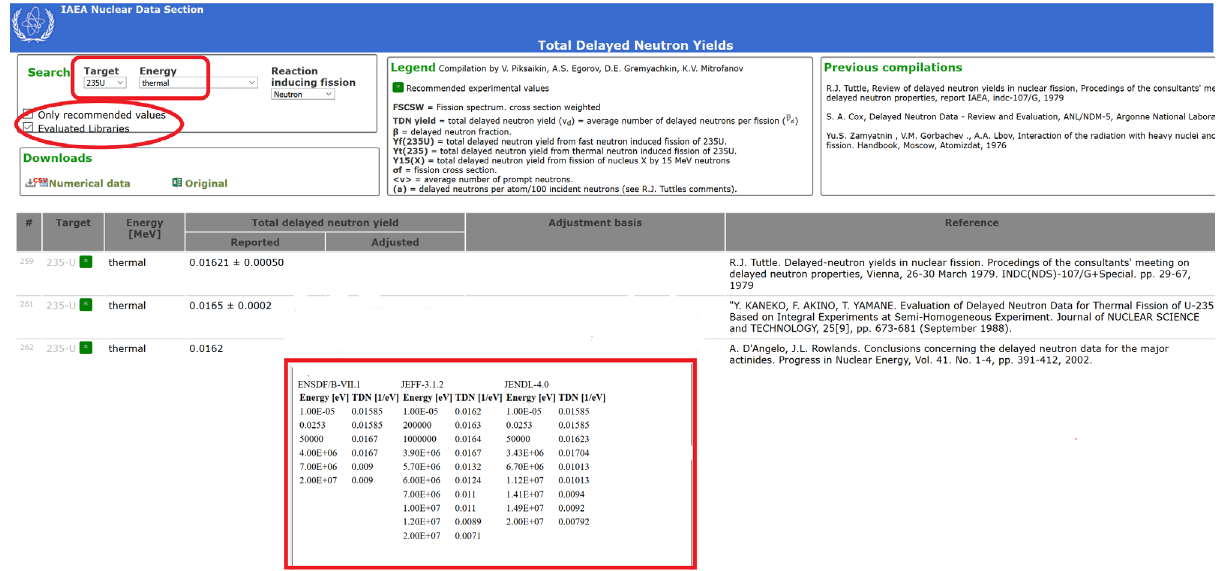
Figure 3. A snapshot of the online Reference Database is shown, where the user can search for experimental total delayed neutron yields for thermal n-induced fission of 235 U and compare with evaluated